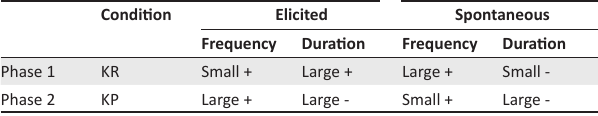
TABLE 1: Effect sizes for